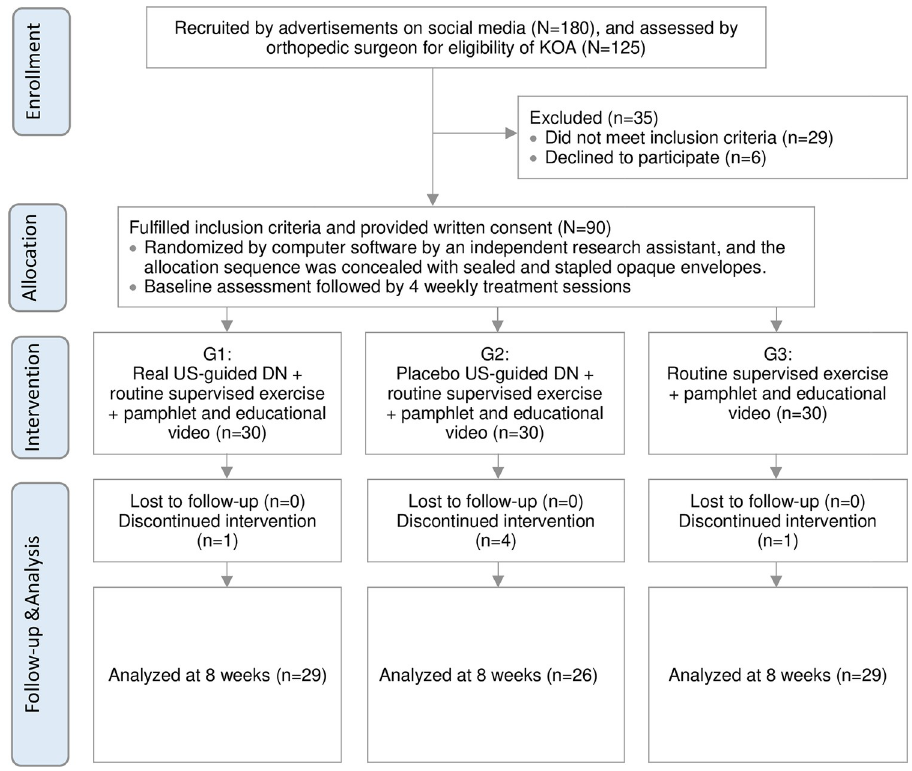
Fig 1. Consolidated Standards of Reporting Trials (CONSORT) flow